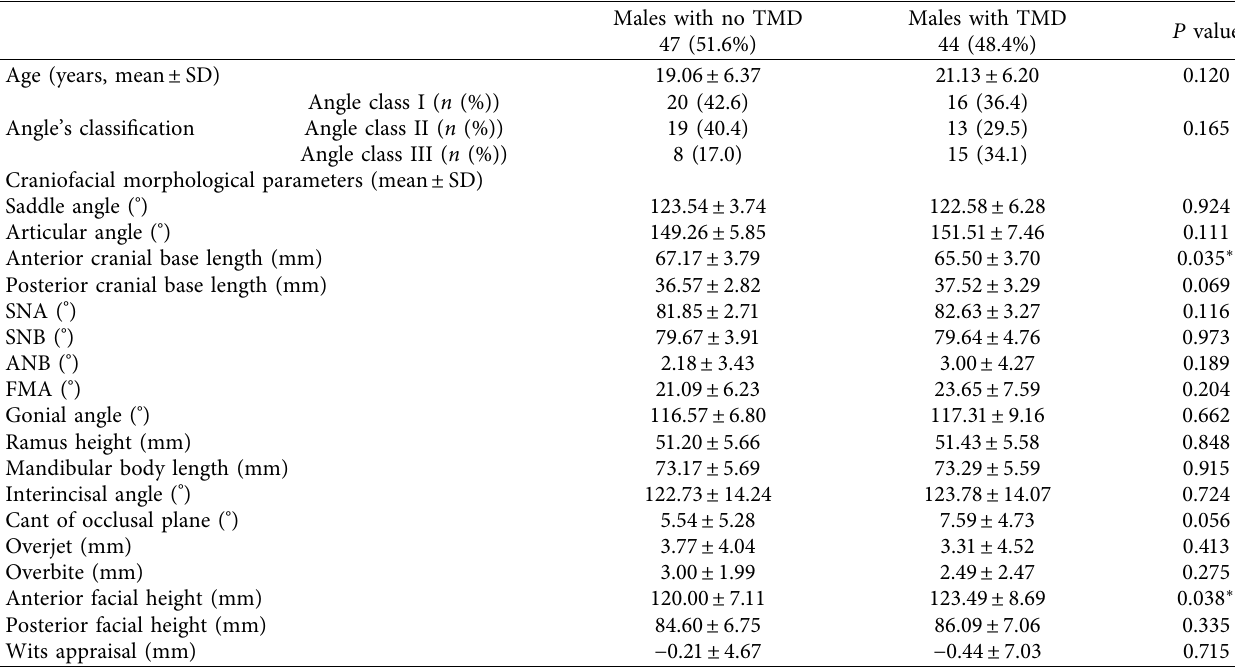
Table 4: Comparison of demographic, occlusal, and craniofacial morphological characteristics between male patients with and without